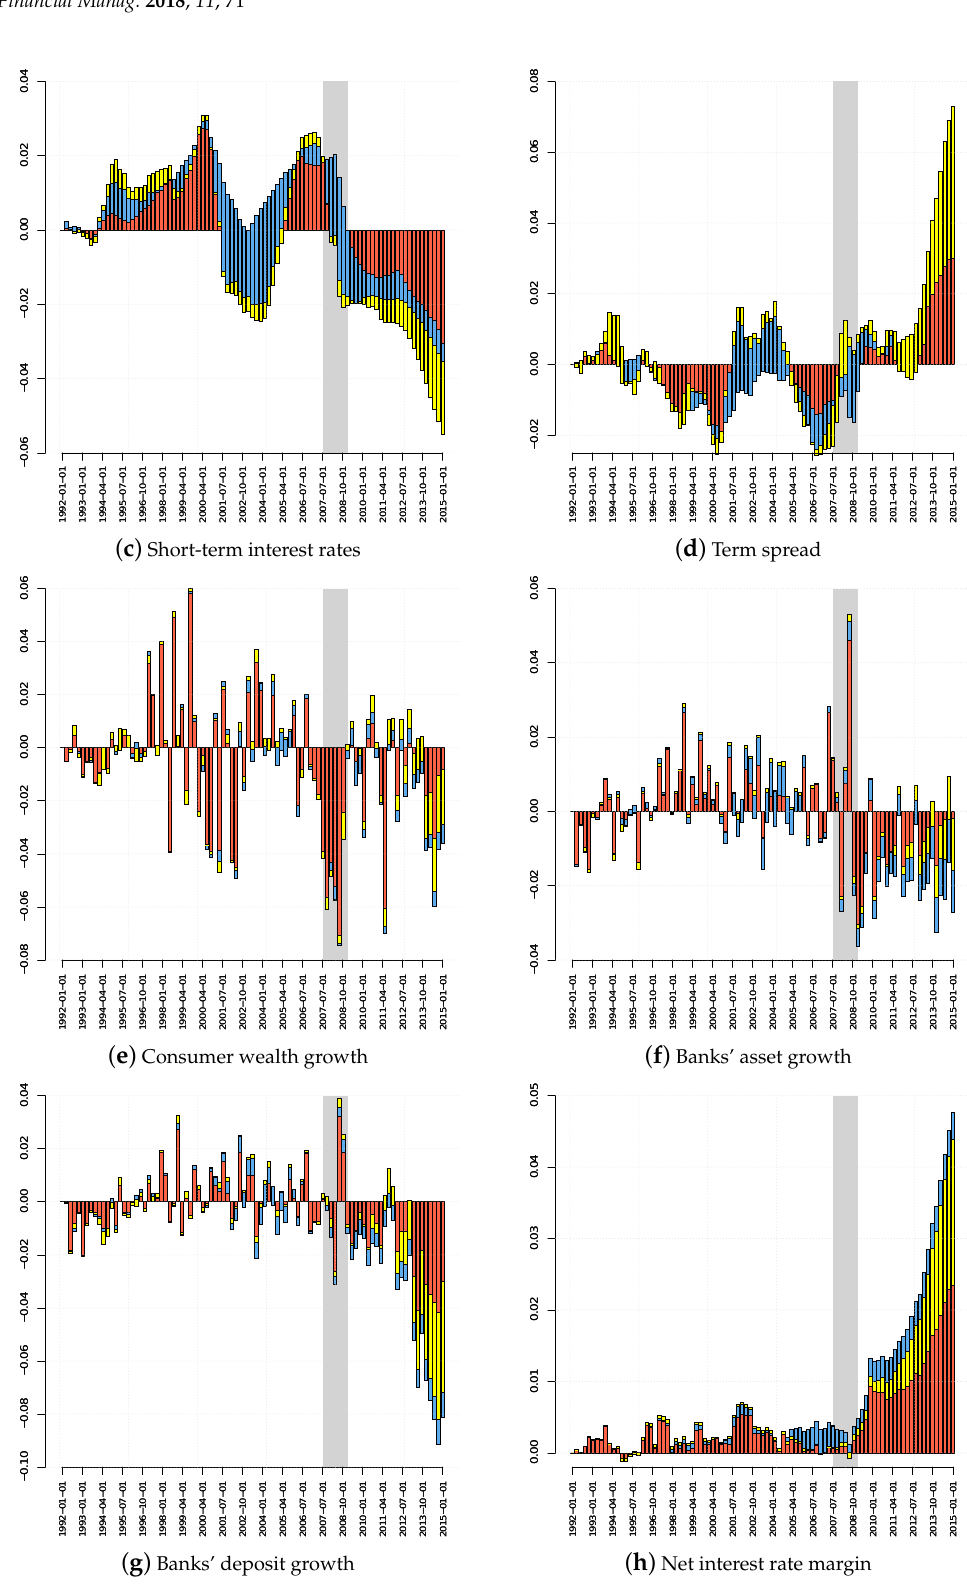
Figure 5. Historical decomposition of time series. Notes: Historical decomposition of time series based on the posterior median. The overall contribution of all shocks except the term spread and monetary policy shock in red. Contributions of the monetary policy shock and the term spread shock in blue and yellow, respectively. The shaded grey area indicates the period of the recession associated with the global financial